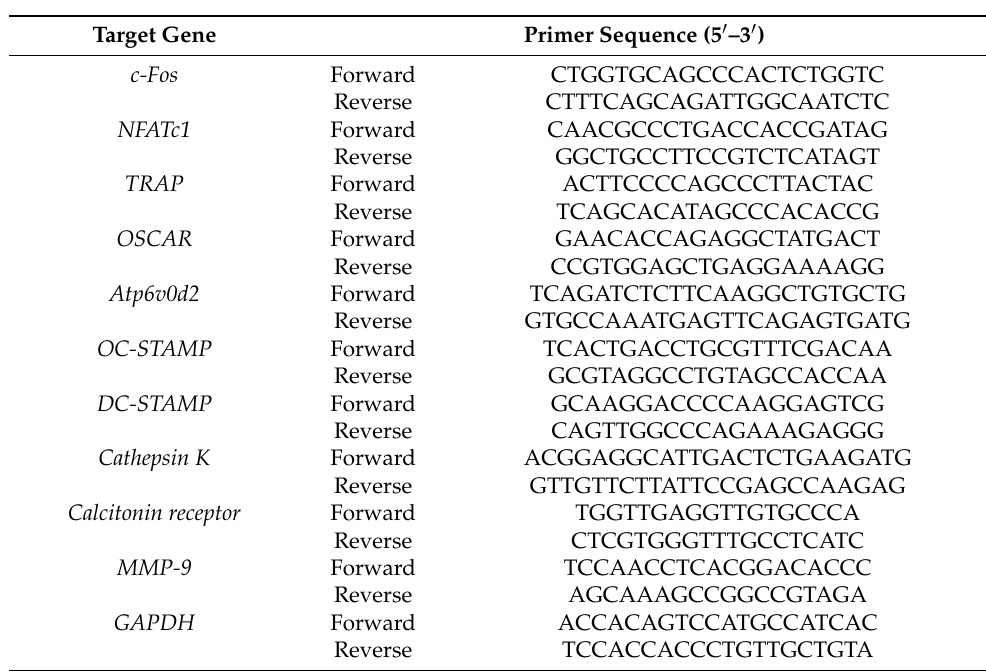
Table 2. Sequences of real-time RT-PCR